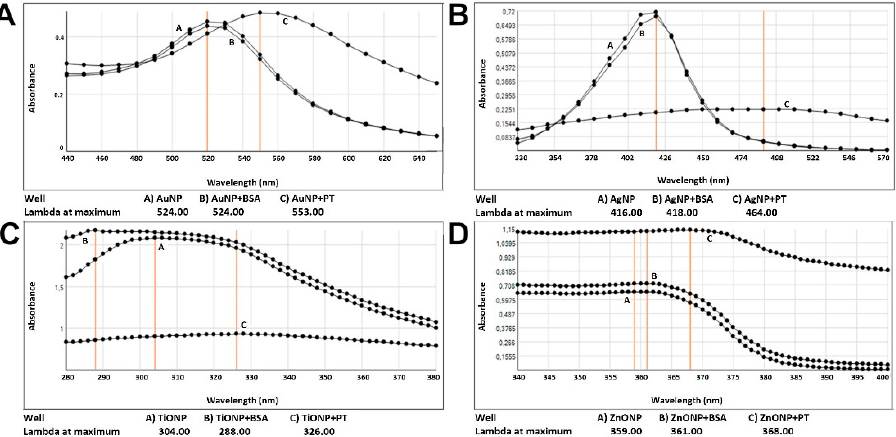
Figure 2. UV–Vis spectra of mNPs. The graphs report the absorbance on the ordinate and the wavelength on the abscissa. ( A ) AuNPs spectra; ( B ) AgNPs spectra; ( C ) TiO2NPs spectra; ( D ) ZnONPs spectra.